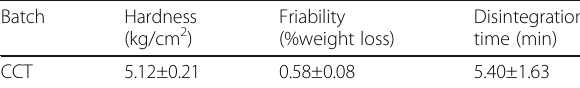
Table 8 Evaluation parameters of tablet of Formulation